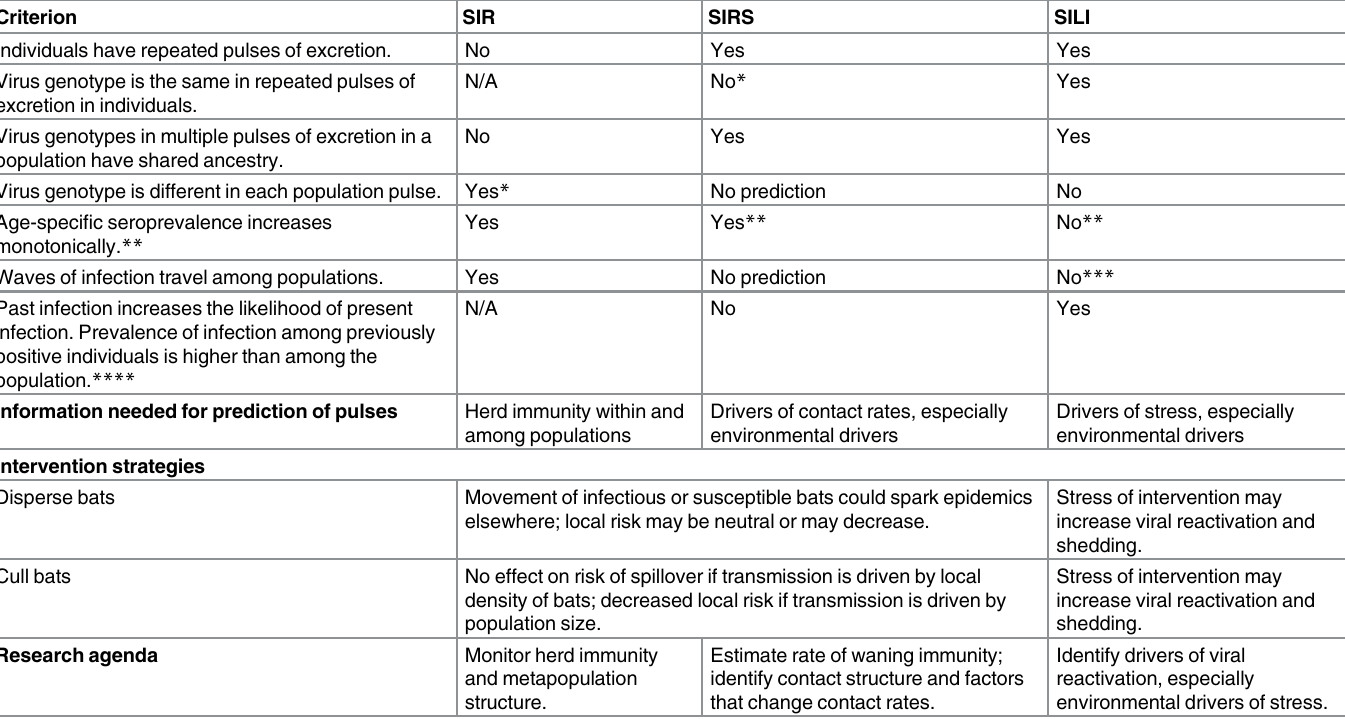
Table 1. Criteria to differentiate Susceptible-Infectious-Recovered (SIR) dynamics, Susceptible-Infectious-Recovered-Susceptible (SIRS) dynam- ics, and Susceptible-Infectious-Latent- Infectious (SILI) dynamics in bats; strategies to predict the likelihood of spillover or to minimize the likeli- hood of spillover for viruses with each type of dynamics; and research that would improve our understanding of bat virus dynamics given each scenario † . Criterion SIR SIRS SILI Individuals have repeated pulses of